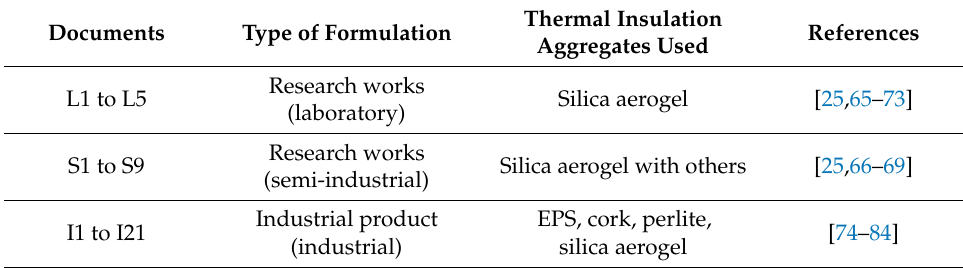
Table 2. References and type of formulations